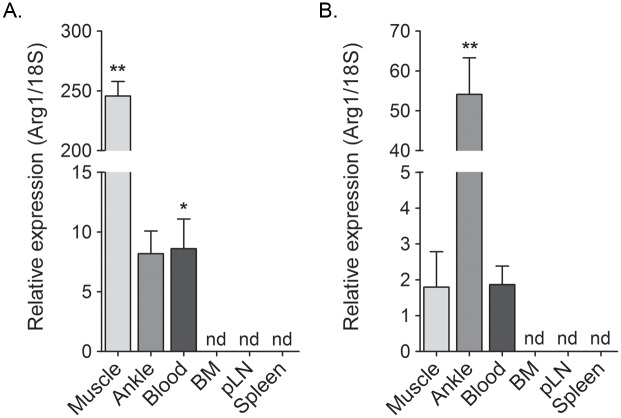
Arg1 is induced in inflamed musculoskeletal tissues and in blood leukocytes but not lymphoid tissues of RRV- and CHIKV-infected mice.WT mice were mock-inoculated (n = 5) or inoculated with 103 PFU of (A) RRV (n = 6) or (B) CHIKV (n = 6). At 10 dpi the gastrocnemius muscle (“Muscle”), ankle/foot joint (“Joint”), circulating blood leukocytes (“Blood”), bone marrow (“BM”) from the femur, the draining popliteal LN (“pLN”), and the spleen were harvested for RT-qPCR analysis of Arg1 expression. Data are combined from two independent experiments, normalized to 18S rRNA levels, and are expressed as the relative expression (n-fold increase) over expression in each tissue from mock-inoculated mice. Each data point represents the arithmetic mean ± SEM. ** P < 0.01, * P < 0.05 as determined by significance test of greater than one.